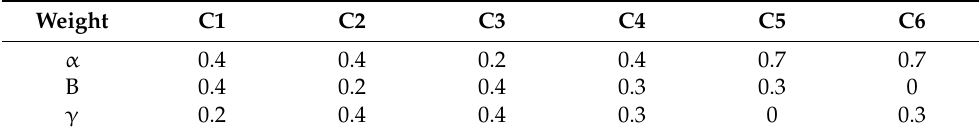
Table 2. Weights of user interest, human relation, and answer quality.